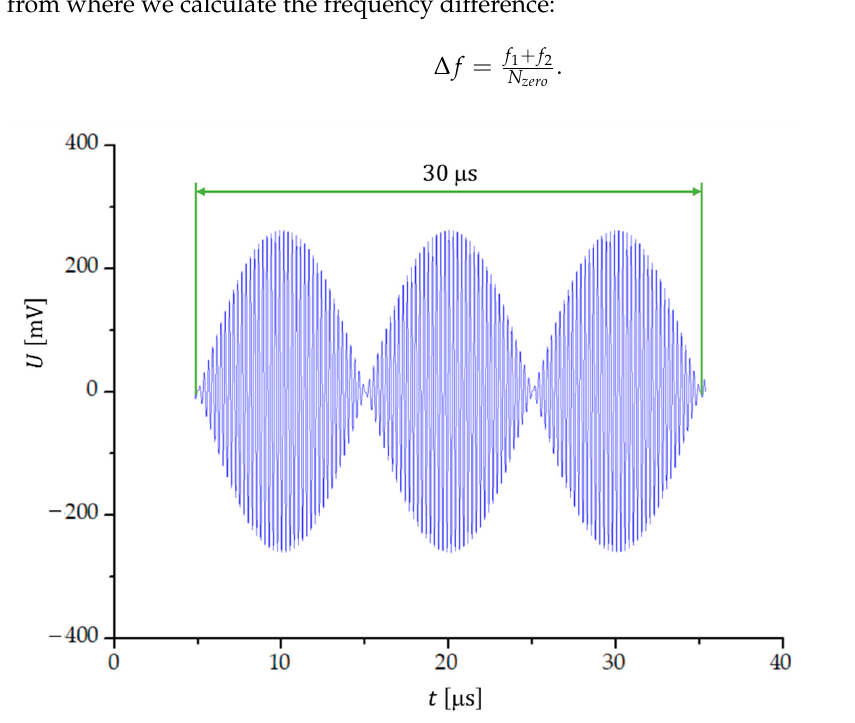
Figure 1. Formation of a beat signal when two signals with frequencies 𝑓 (cid:2869) (cid:3404) 3.95 MHz and 𝑓 (cid:2870) (cid:3404) 4.05 MHz are summed. The beat period is 10 μ s